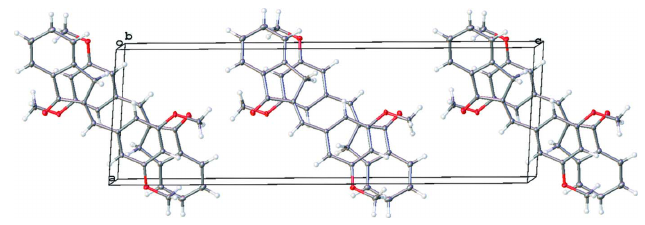
Figure 3 Packing diagram of 1b viewed along the b axis.